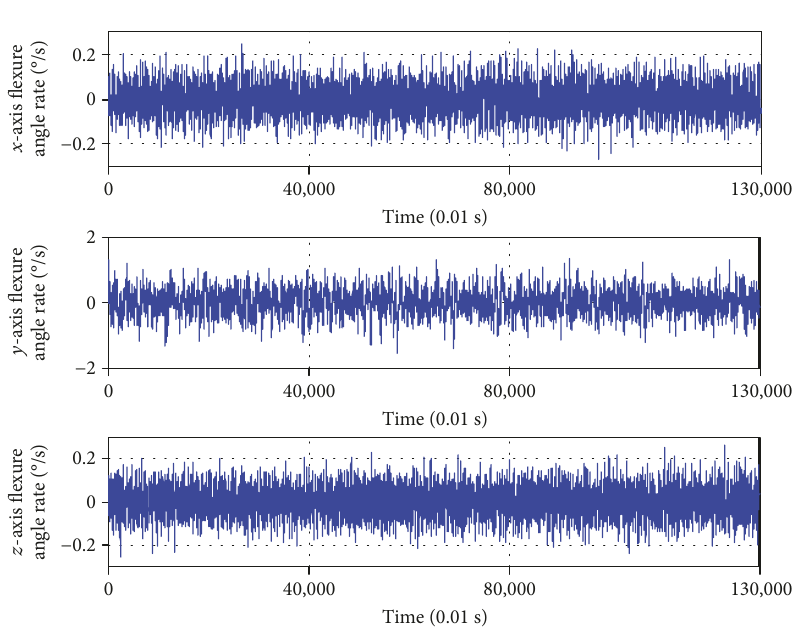
Figure 6: Flexure angle rate on x -axis, y -axis, and z -axis.